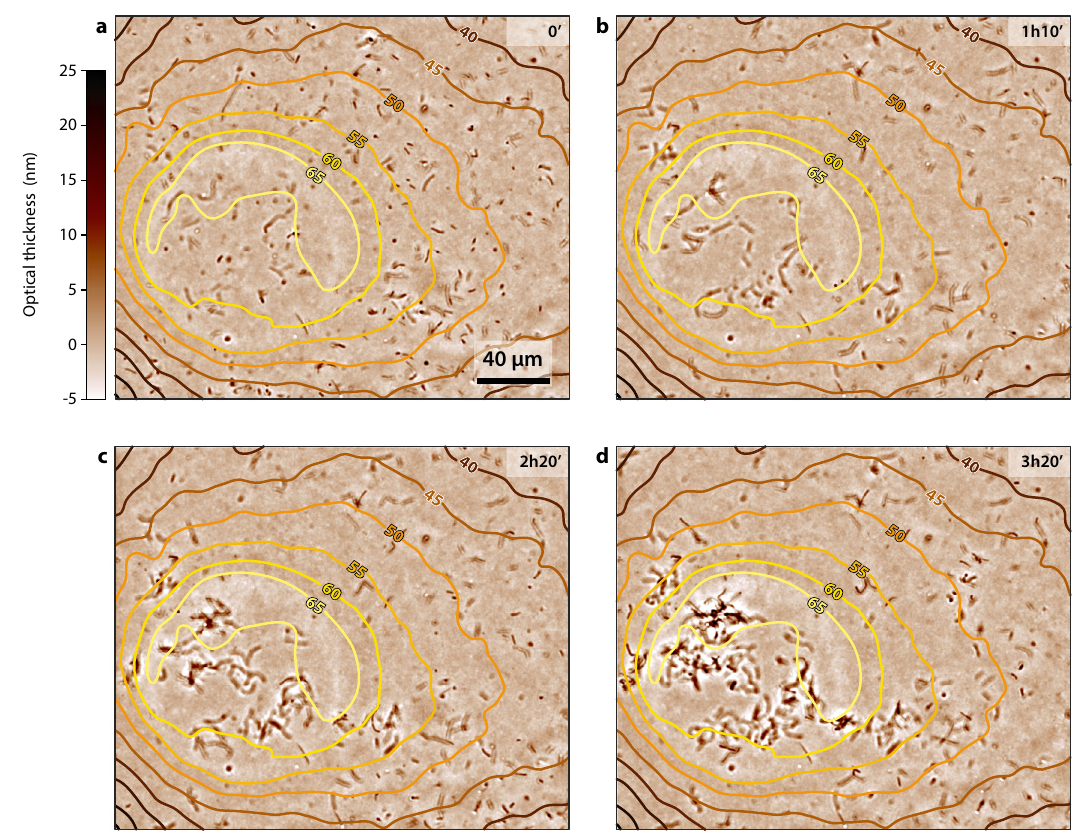
Fig.3|Laseractivatedgrowthofbacteria. Opticalthicknessimagesofthegrowth of G.stearothermophilus bacteriaupon laserheating atdifferenttime,( a ) t =0min, ( b ) 1h 10min, ( c ) 2h 20min, ( d ) 3h 20min, extracted from a 200min long movie